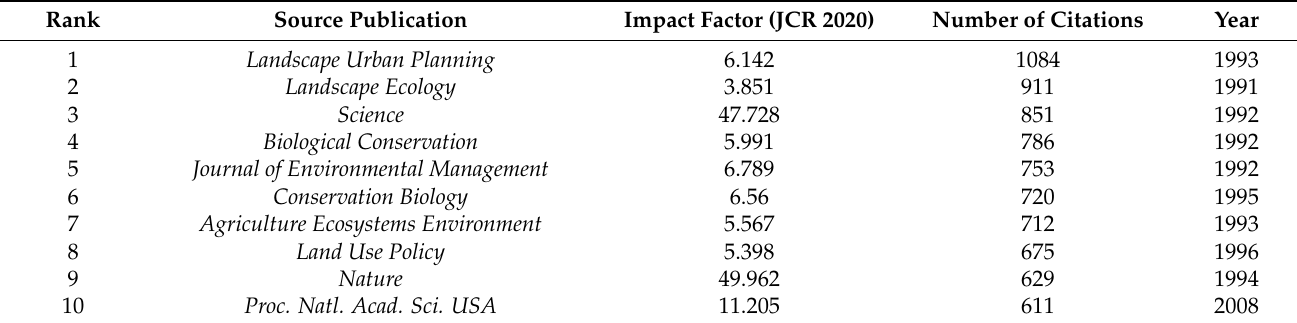
Table 1. Most cited journals in the RLES literature.